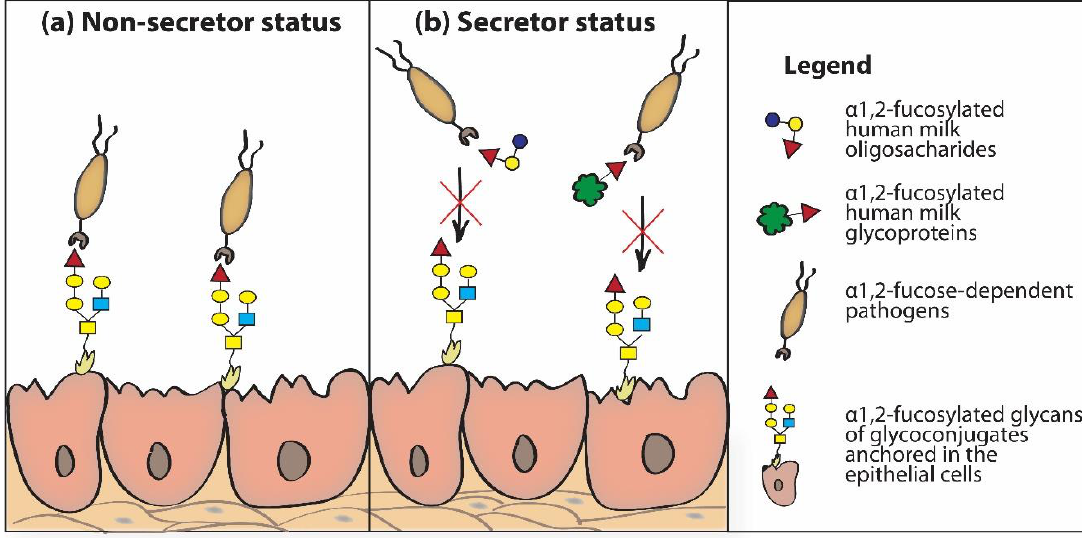
Figure 4. The impact of non-secretor ( a ) and secretor ( b ) status of mother on inhibition of α 1,2-fucose dependent pathogen adhesion to epithelial cells of the newborn’s/infant’s gastrointestinal tract [117,118].